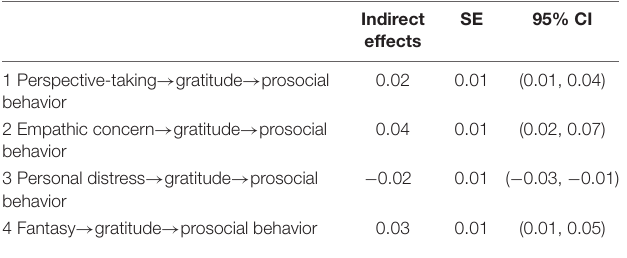
TABLE 2 | Bootstrap analyses of the magnitude and statistical significance of indirect